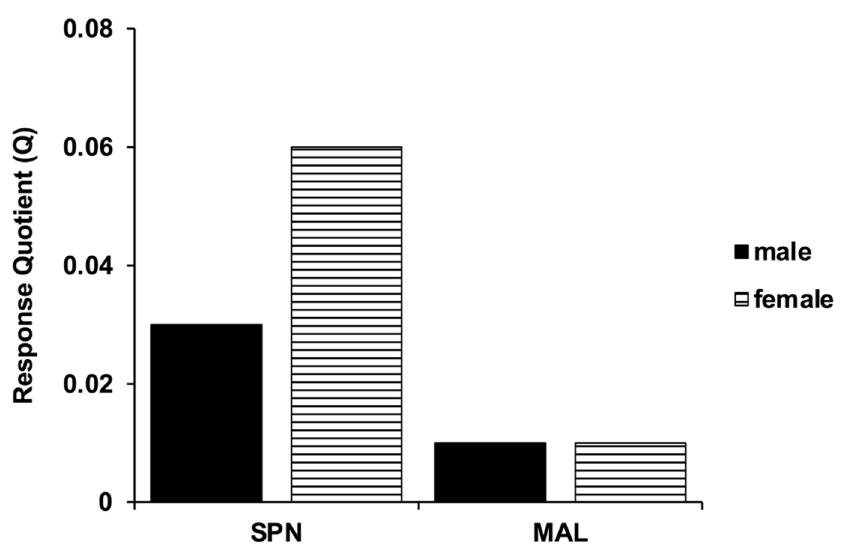
Figure 2. Response quotient (Q) comparing rates of resistance against spinosad and malathion in adult D. suzukii populations selected for resistance in the laboratory.